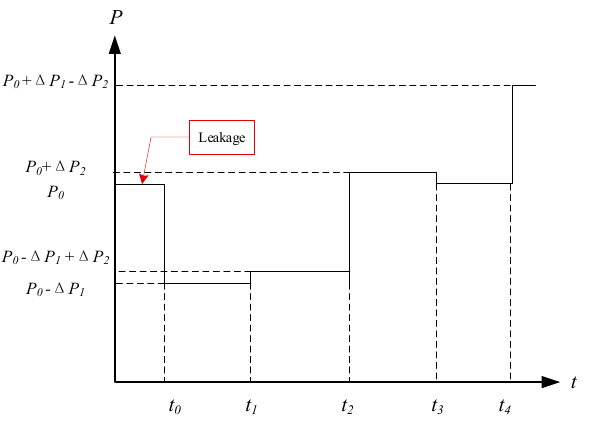
Figure 10. Curve of pressure–time. Figure 10. Curve of